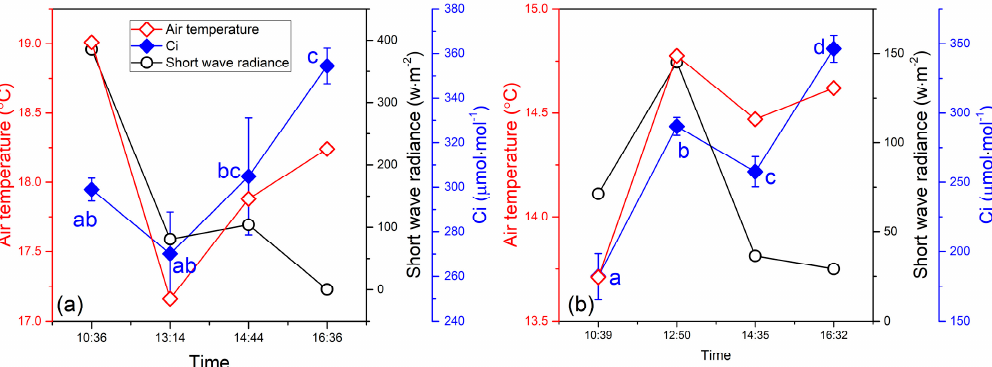
Figure 8. Diurnal patterns of intercellular carbon dioxide concentration (Ci) accompanied by the air temperature and short-wave radiation for ( a ) soybean results and ( b ) sweet potato results. The air temperature and short-wave radiation were collected with an interval time of one hour in a meteorological station that was ~300 meters away from our experimental site. Signi fi cant differences (P < 0.05) between the mean values in the fi gure are marked by different letters above symbols, while the letters with a same letter showed that the difference is not signi fi cant. For example, as shown in Figure a, the letters “ab” and “bc” corresponding to the second and third measurement of Ci represent that their difference is insigni fi cant, while the letters “ab” and “c” corresponding to the second and fourth one represent that the difference is signi fi cant.